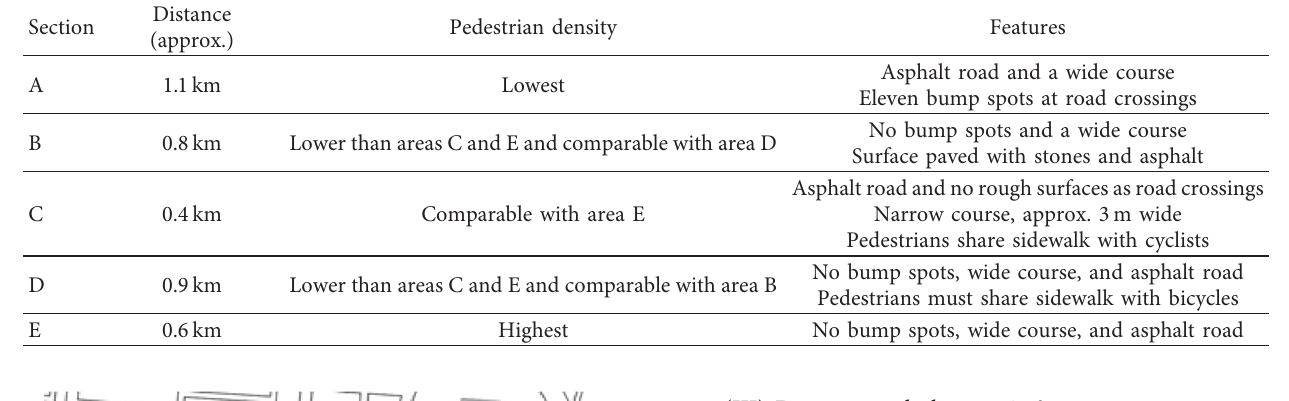
Table 3: Features of each section.